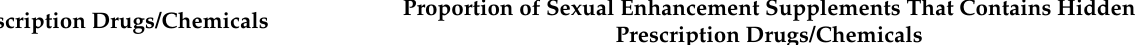
Table 2. Estimation of hidden prescription drugs and chemicals in sexual enhancement supplements.